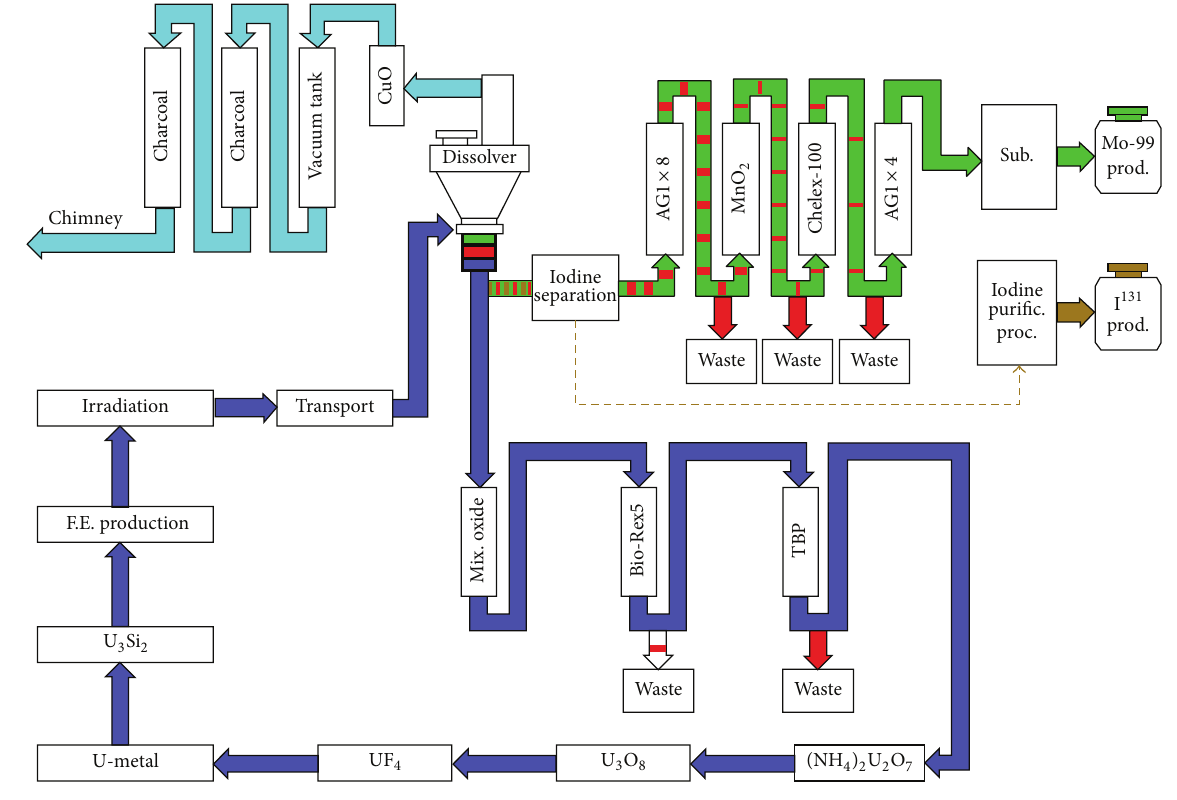
Figure 14: Simplified scheme of the U 3 Si 2 production cycle.